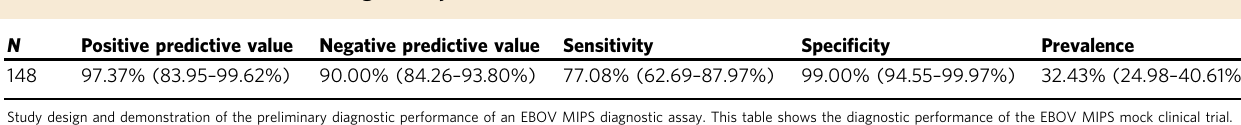
Table 4 EBOV mock clinical trial diagnostic performance